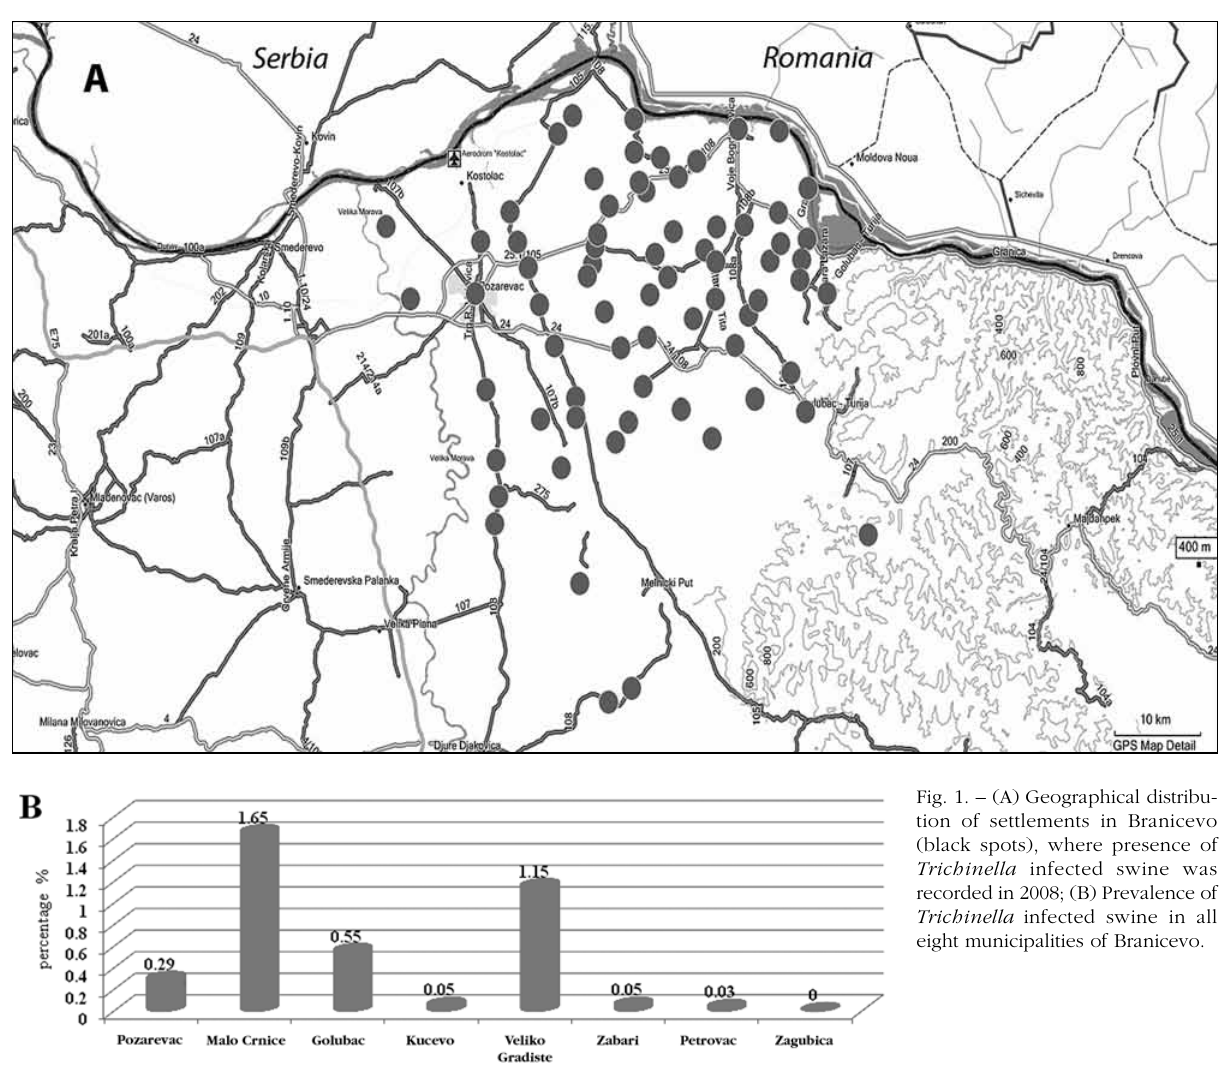
Fig. 1. – (A) Geographical distribu- tion of settlements in Branicevo (black spots), where presence of Trichinella infected swine was recorded in 2008; (B) Prevalence of Trichinella infected swine in all eight municipalities of